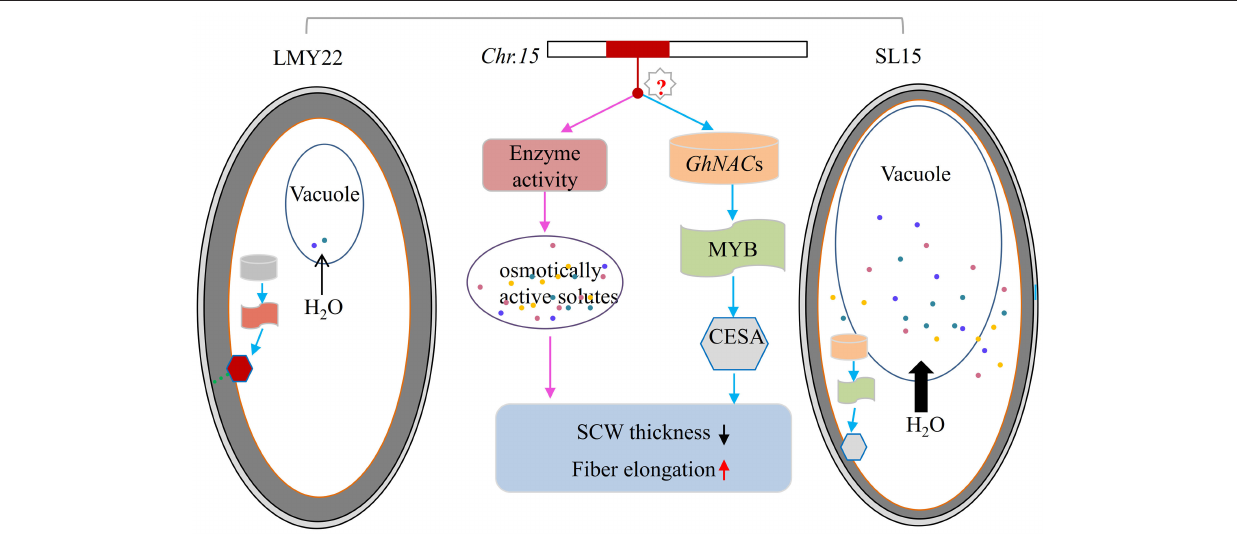
FIGURE 7 | Model of fiber secondary cell wall thickening in LMY22 and SL15. Light gray and dark gray ovals respectively represent the cotton fiber primary cell wall and secondary cell wall (SCW); the orange oval represents the plasmalemma of the cotton fiber cell. Cylinders represent GhNACs that negatively regulate fiber SCW development, with orange and light gray indicating DEGs with up- or downregulated expression, respectively. Oblong waves represent MYBs involved in cellulose biosynthesis, with brick red and light green indicating DEGs with up- or downregulated expression, respectively. Hexagons represent cellulose synthase or cellulose-synthase-like genes, with bright red and light gray indicating DEGs with up- or downregulated expression, respectively. Colored dots represent various osmotically active solutes. Black arrows qualitatively represent the amount of water flowing from cytoplasm into